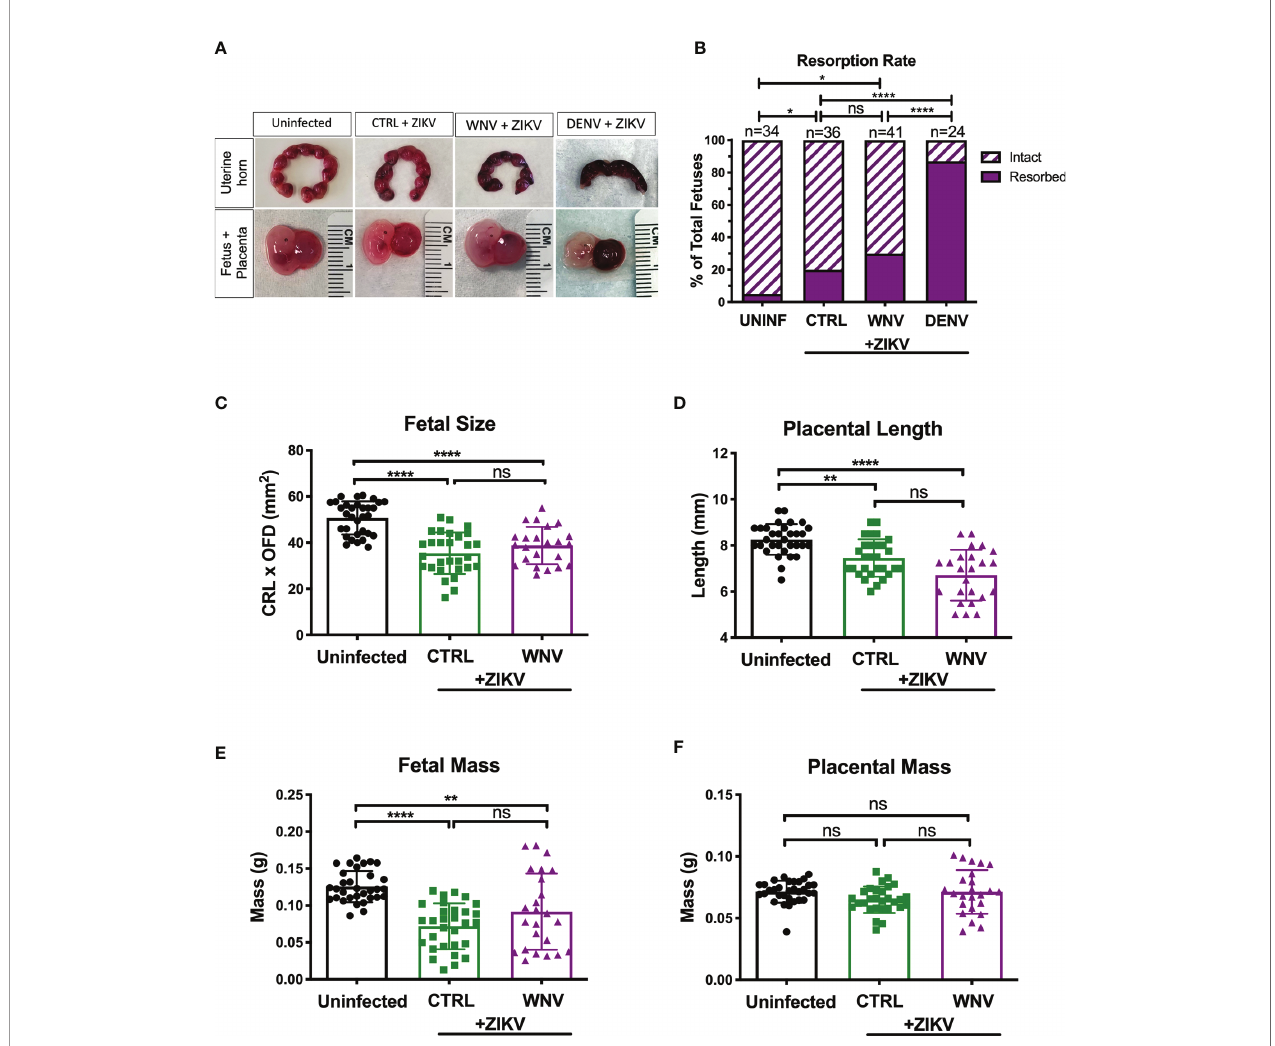
FIGURE 3 | Impact of WNV antibodies on ZIKV-infected fetuses. Uterine horns were harvested and morphologically examined at E13.5 from ZIKV-infected or uninfected dams ( A , top). Fetal and placental pairs were isolated from each harvested conceptus, and representative images are shown ( A , bottom). The resorption rate across all pregnancies are represented by the proportion of resorbed and intact fetuses (B) ; uninfected mice (n=34), CTRL (n=36), WNV (n=41), and DENV (n=24). Signi fi cance between groups was determined by c 2 analysis. Intact fetuses and placentas were measured for fetal size (C) by multiplying the crown-to-rump length (CRL) by the occipital-frontal diameter (OFD), placental length (D) , represented by diameter, fetal mass (E) , and placental mass (F) . Signi fi cance for (C – F) was determined by a one-way ANOVA, with a Kruskal-Wallis post-test for multiple comparisons between uninfected mice (n=32), CTRL (n=29) and WNV (n=24). Bar plot overlays for (C – F) depict mean and SD. Resorbed and partially resorbed fetuses were excluded from the analysis in (C – F) . ns, not signi fi cant; * p < 0.05, ** p < 0.01, **** p <